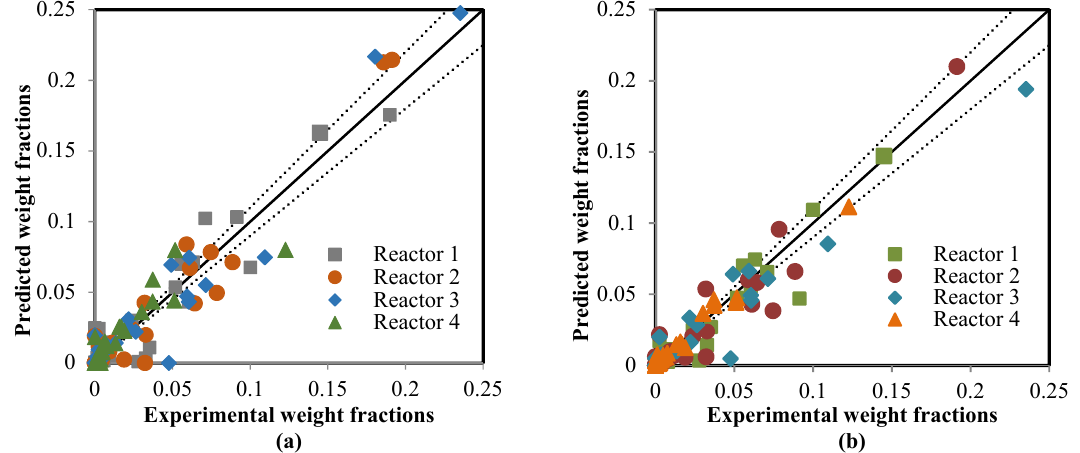
Figure 6. Comparison between the real and predicted weight fractions: ( a ) mathematical model, and ( b ) artificial neural network.